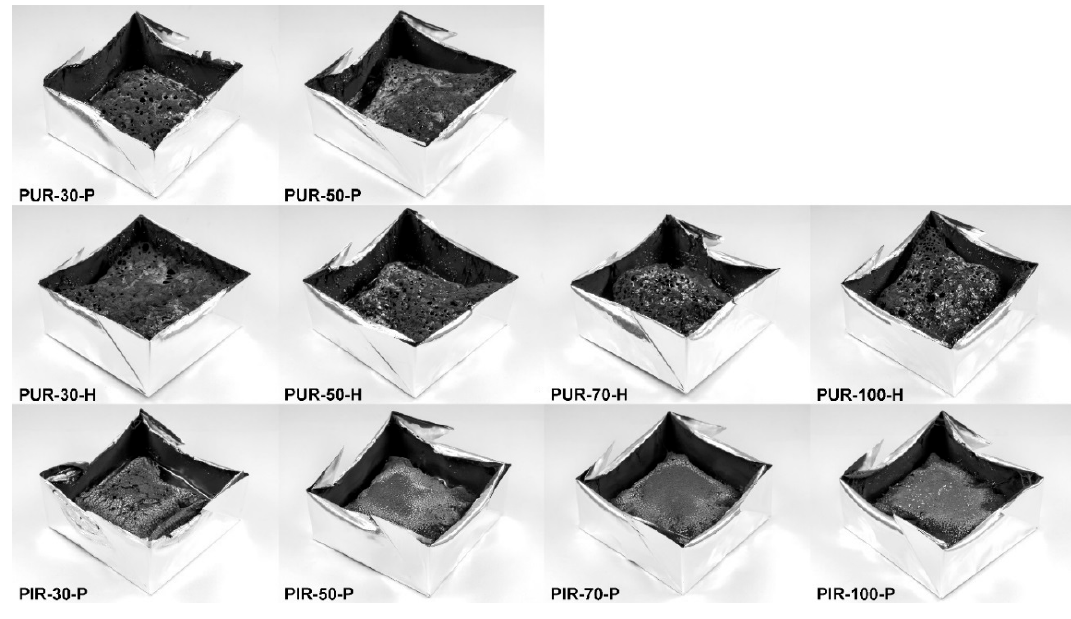
Figure 5. Cone calorimeter residues of PUR-P, PUR-H, and PIR-P foams.